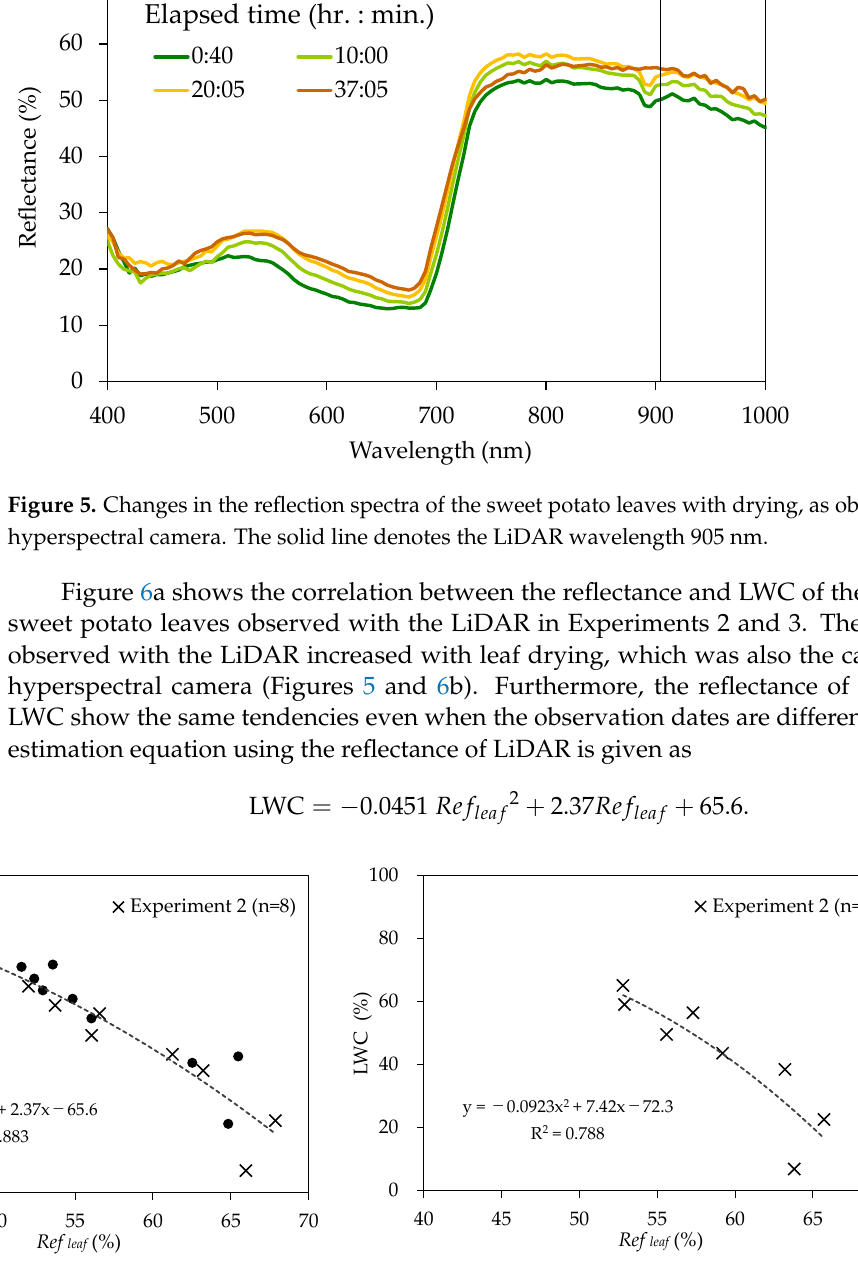
Figure 4. Changes over time in the DN of the standard reflection panel ( DN std ) related to the body temperature of the LiDAR ( BT ). ( a ) Changes over time in the DN std and the BT after a cold start; ( b ) Correlation between the DN std and the BT . The dashed line denotes the regression line.